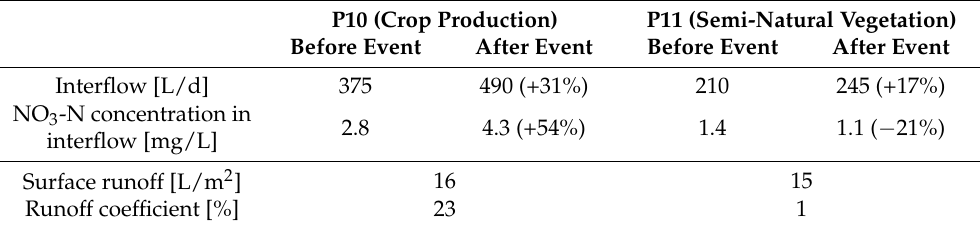
Table 3. Observations of hydrological parameters related to a single rain storm on 14 November